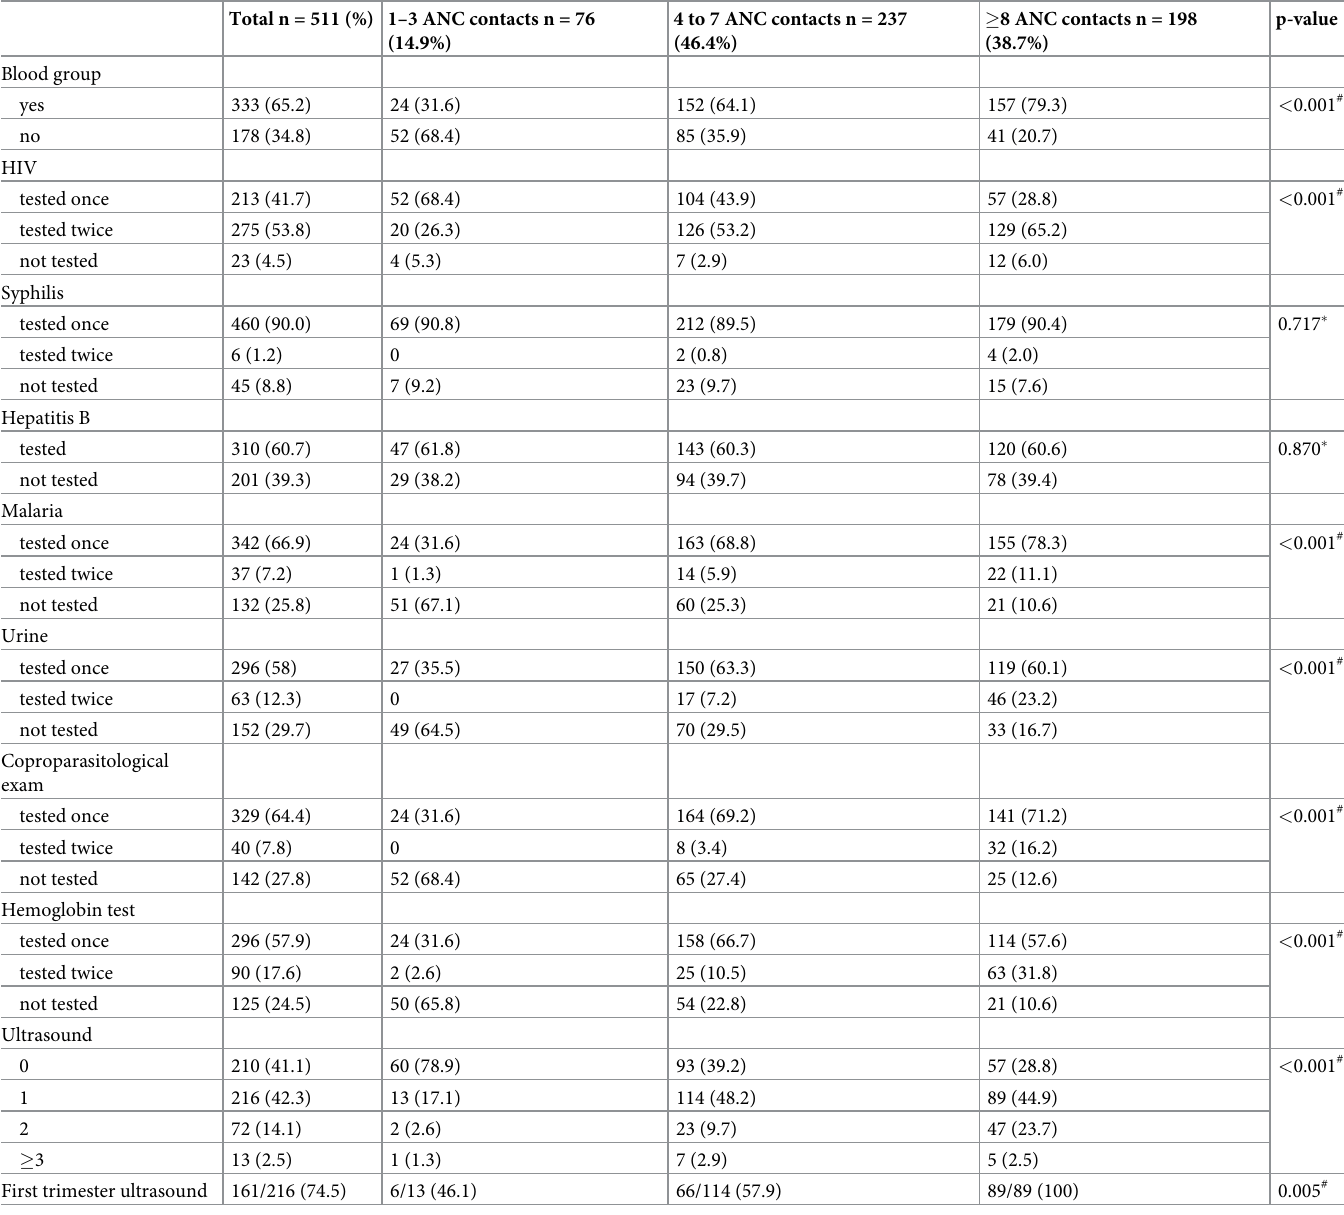
Table 1. Screening completion comparison according to the frequency of ANC contacts: Inadequate (1 to 3), adequate (4 to 7) and complete ( � 8). Total n = 511 (%) 1–3 ANC contacts n = 76